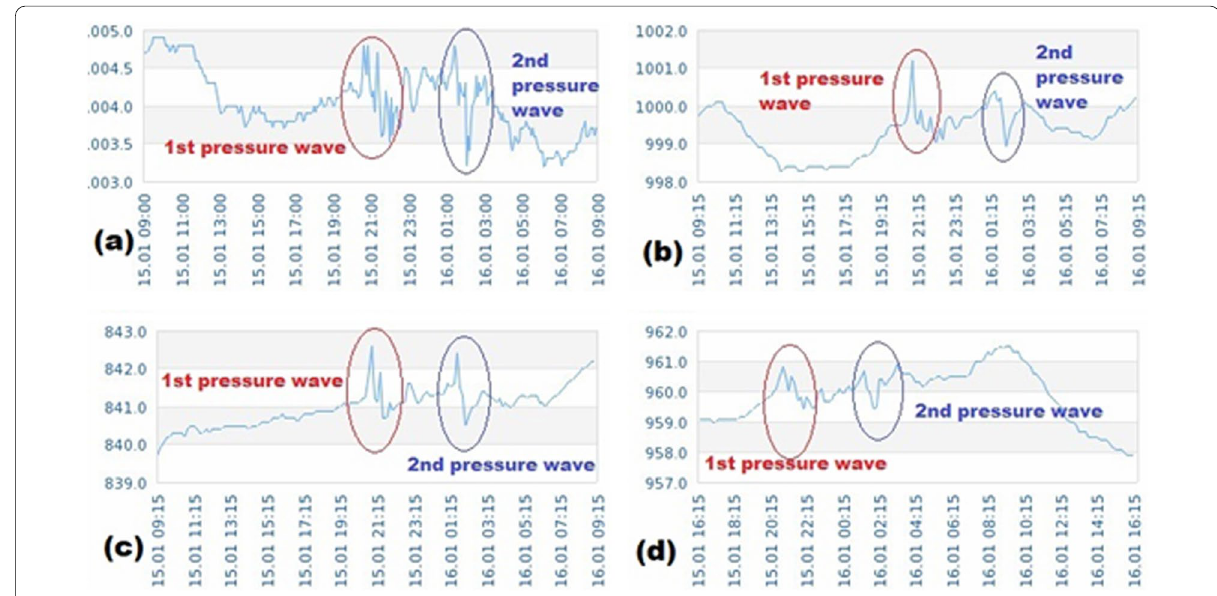
Fig. 7 Graphic representation of air pressure changes in hPa on MS in Serbia on 15 and 16 January 2022: a Belgrade, b Čačak, c Stara planina and d Kosovska Mitrovica (x-label denotes date and time: 15.01. 09:15